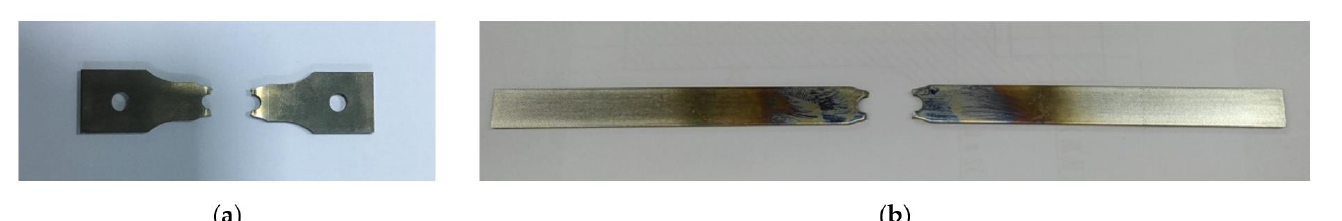
Figure 19. The fracture of the specimens after testing: ( a ) Clamped by pin holes; ( b ) Clamped by hydraulic pressure.